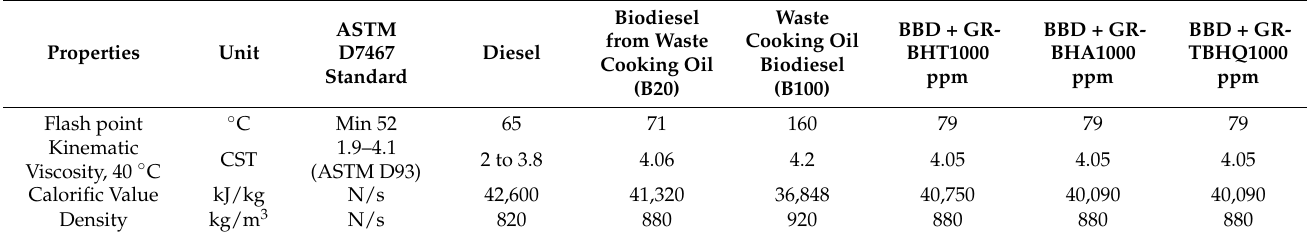
Table 2. Fuel physical property in comparison with standard.